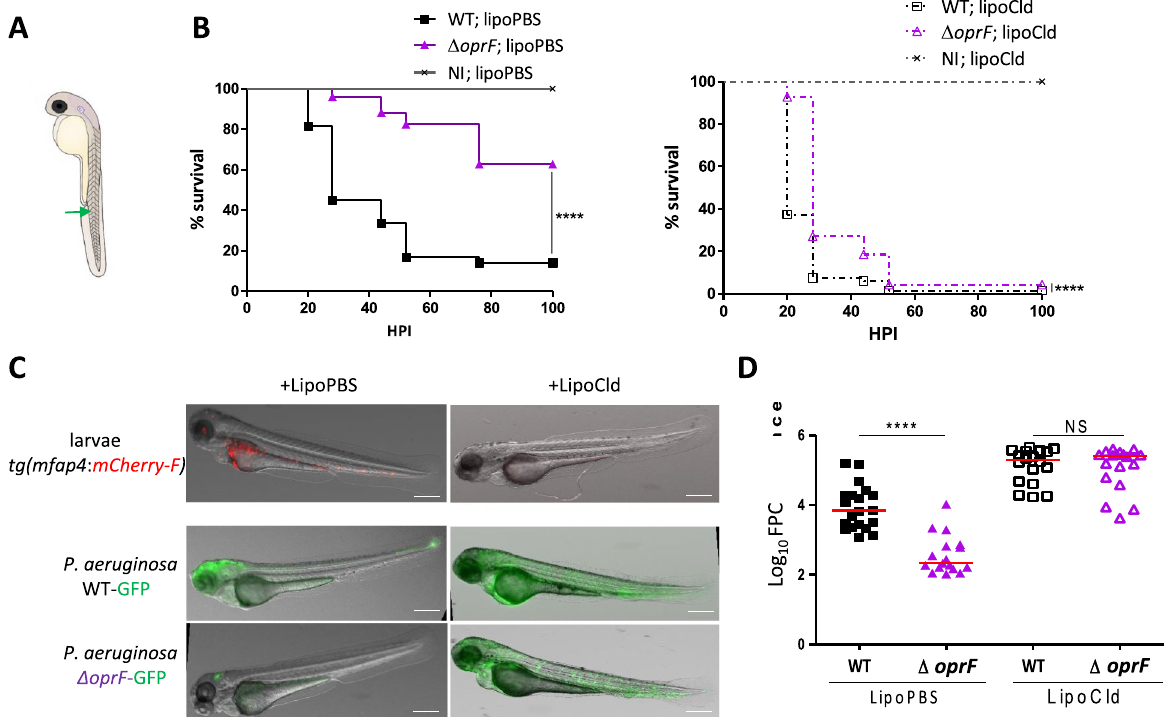
Figure 1. The P. aeruginosa Δ oprF mutant is attenuated in zebrafish embryos in a macrophage-dependent manner. ( A ) Diagram of 50 h post-fertilization (hpf) zebrafish embryo showing the caudal vein injection site (green arrow). ( B ) Survival curves of embryos infected with PAO1 wild-type stain or PAO1 Δ oprF mutant. Non infected embryos (NI) were used as control. Embryos were either treated with LipoPBS (left panel) or with LipoCld (right panel) to deplete macrophages. Approximately 3500 CFU P . aeruginosa were microinjected into the caudal vein (n = 50–70 for infected embryos and n = 30 for NI embryos, pool of three independent experiments). Results are expressed as the percentage of surviving embryos at different times post-infection. ( C ) Representative fluorescence images of embryos infected by either wild-type or Δ oprF P. aeruginosa (at 20 hpi) in the context of LipoPBS or LipoCld treatment. The efficiency of macrophages depletion is shown in the upper panels with the visualization of red macrophages. Scale bar 400 µm. ( D ) Quantification of bacterial loads (fluorescence pixel counts) from two independent experiments. Each symbol represents individual embryo (n = 18–20) and horizontal lines indicate the median values. Statistical significance was determined by log-rank test ( B ) or one-tailed Mann–Whitney’s test ( D